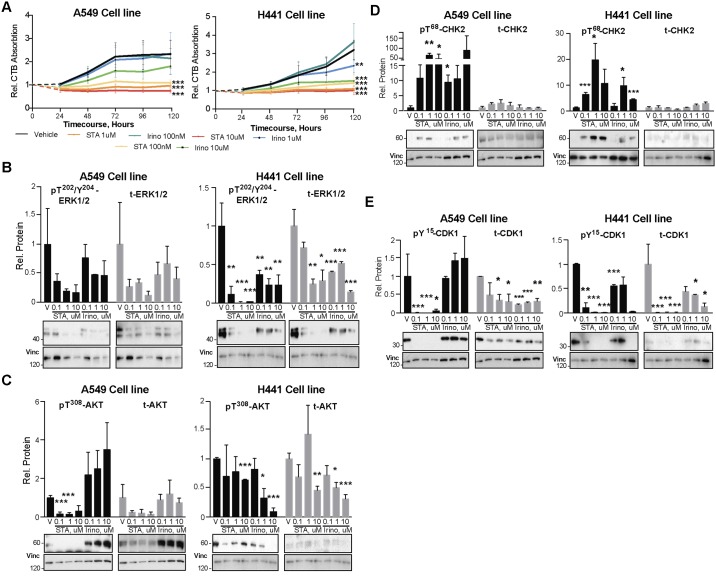
STA-8666 is more effective than irinotecan in controlling the growth of NSCLC cell lines in vitro.A. Quantification of CellTiterBlue (CTB) viability assay in human A549 and H441 NSCLC cell lines treated with vehicle, STA-8666 and irinotecan in doses of 0.1, 1, 10 μM for up to 5 days. Chart curves represent average data from two independent runs performed with duplicate samples. B-E. Western blot analysis of phosphorylated (p) and total (t) ERK1/2 (B), AKT (C), CHK2 (D) and CDK1 (E) protein expression in human A549 and H441 NSCLC cell lines, at 48 hours after treatment with vehicle (V), STA-8666 and irinotecan in doses of 0.1, 1, or 10 μM, as indicated. Histograms represent data from two independent experiments. All graphs: *, p≤0.05; **, p≤0.01; ***, p≤0.001 relative to vehicle controls.